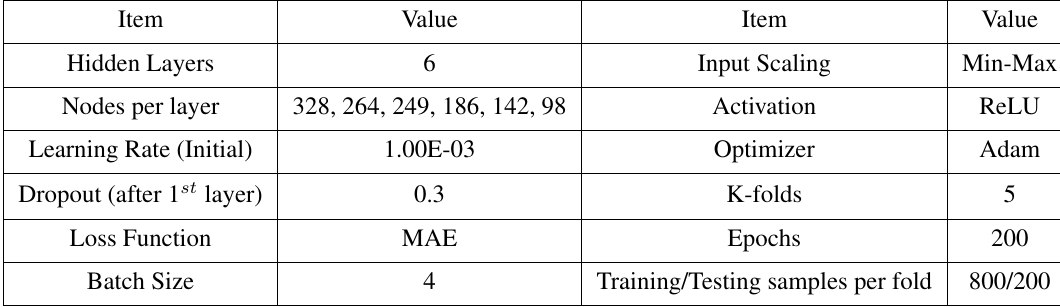
Table 1: Optimum DNN hyperparameters